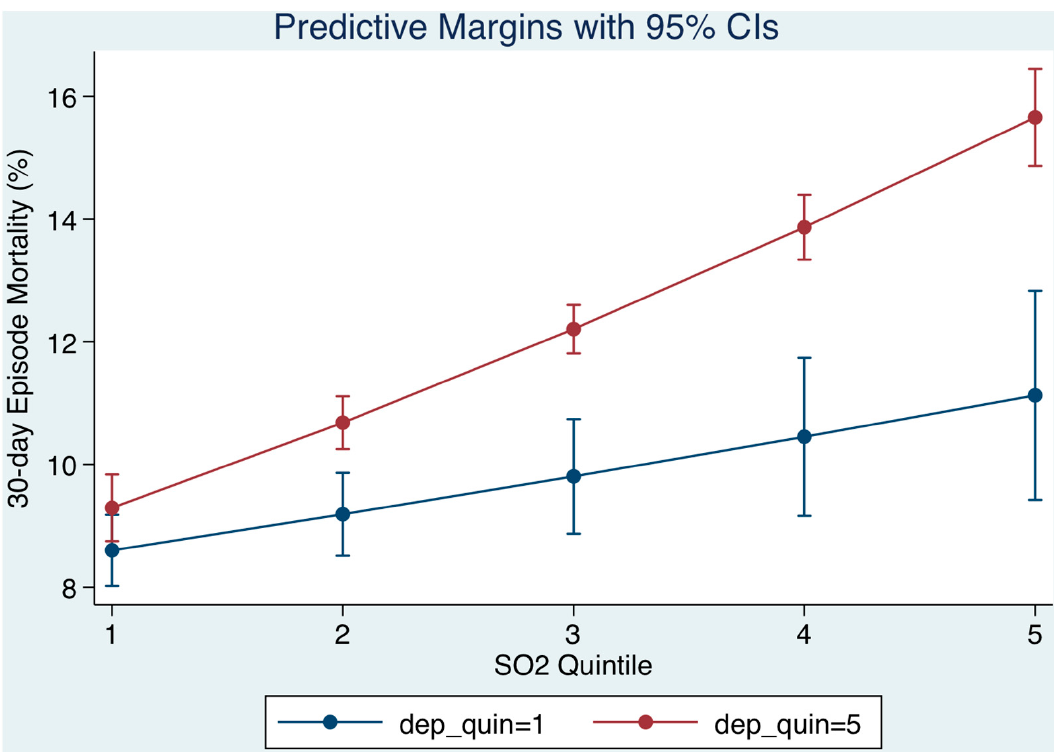
Figure 3. The 30-day in hospital mortality related daily sulphur dioxide (SO 2 ) levels by quintiles to the 30-day in-hospital mortality and adjusted for socio-economic status (SES) and other outcome predictors. We used margins to estimate the average marginal effect. As SO 2 quintiles increased (the level of SO 2 on day of admission), the 30-day mortality progressively increased, but was higher for patients of lower SES.